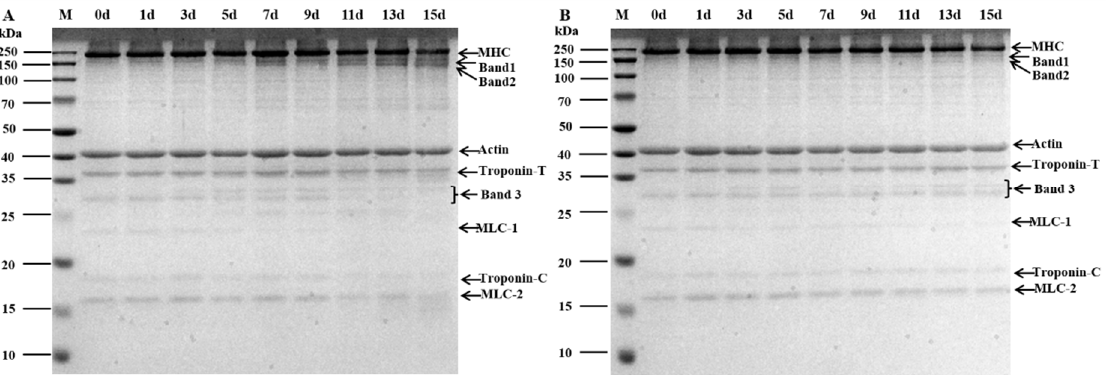
Figure 5. Myofibrillar proteins changes in SDS-PAGE of Coregonus peled fillets during 4 °C refriger- ation ( A ) and − 3 °C super chilling ( B ) storage. M: